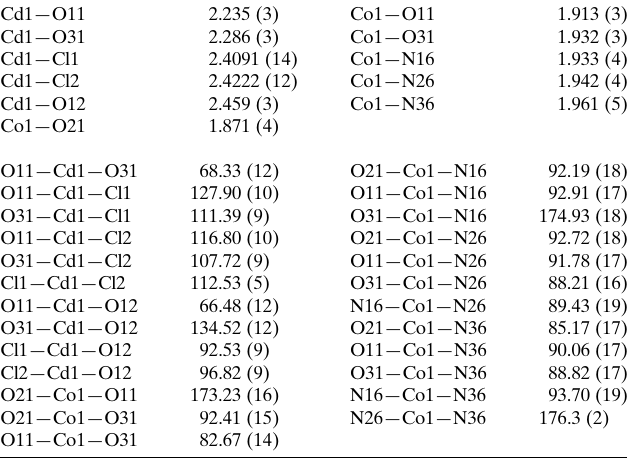
Table 1 Selected geometric parameters (A˚ , (cid:3)